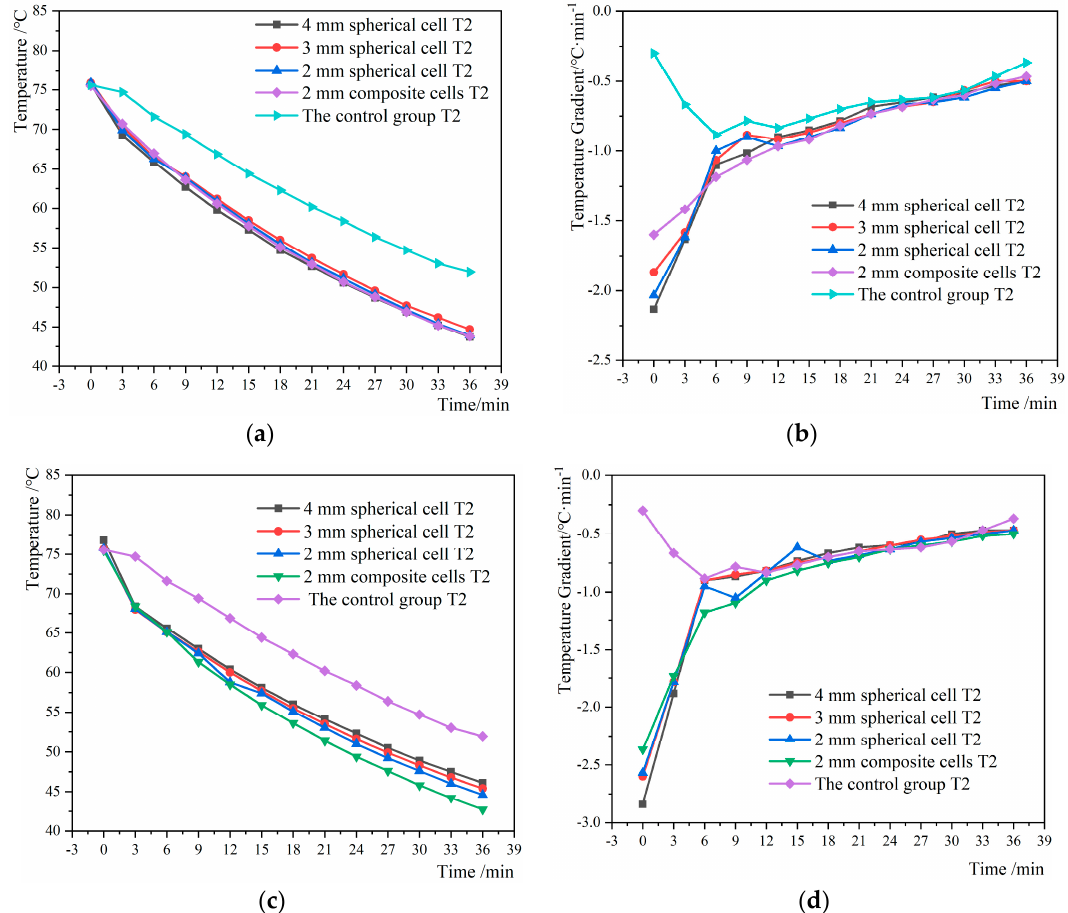
Figure 8. Test results of natural convection heat dissipation. ( a ) Aluminium foam heat dissipation curve. ( b ) Aluminium foam heat dissipation temperature gradient curve. ( c ) Copper foam heat dissipation curve. ( d ) Copper foam heat dissipation temperature gradient curve.